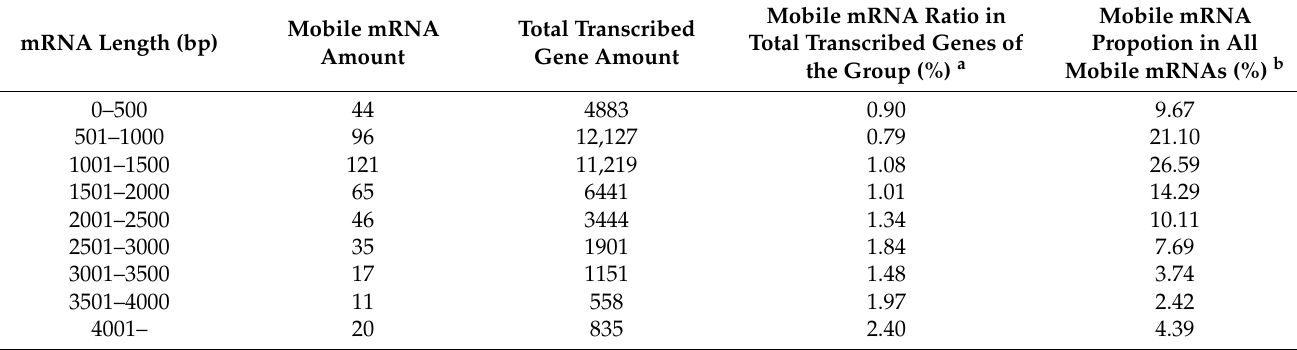
Table 1. mRNA length and transfer ratio in the rootstock of 9901/YJ.